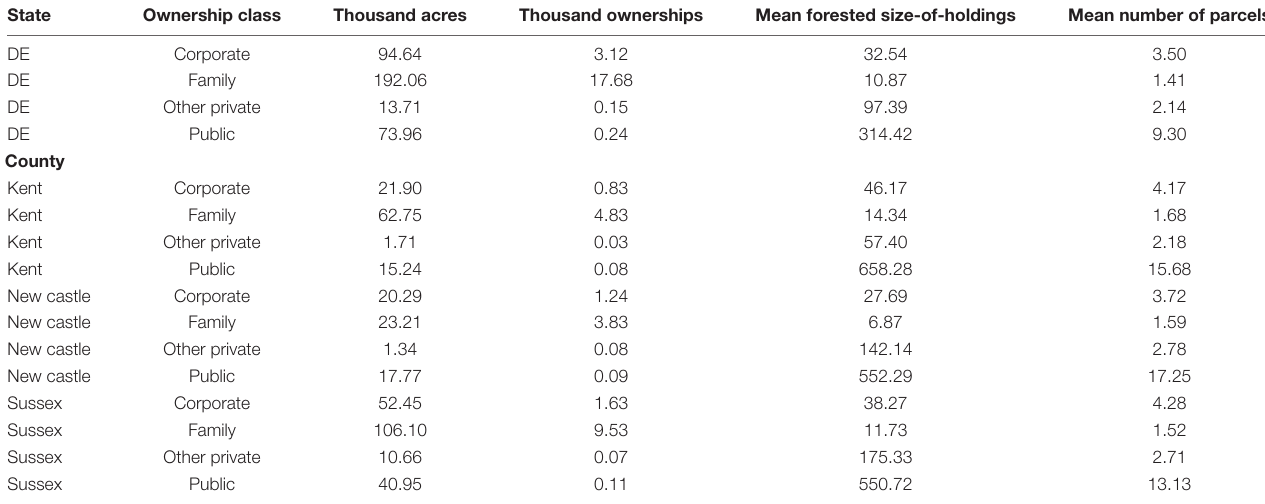
TABLE 1 | Total number of ownerships, total acreage, mean size of forest holdings, and mean number of forested parcels, by Ownership Class, statewide and by counties, as derived from a state-wide ownership and land use